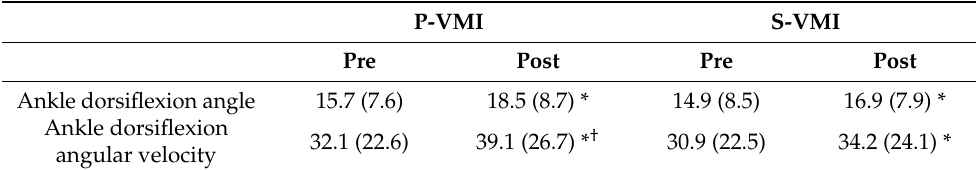
Table 3. Results of ankle dorsiflexion function. P-VMI S-VMI Pre Post Pre Post Ankle dorsiflexion angle Ankle dorsiflexion 39.1 (26.7) * † 30.9 (22.5) 34.2 (24.1) *